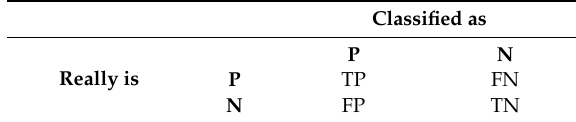
Table 2. Confusion matrix of binary classification